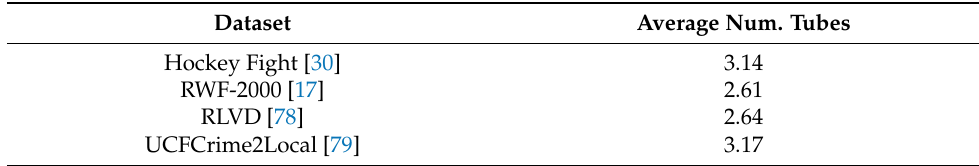
Table 7. Average number of action tubes per video for each dataset extracted with the proposed